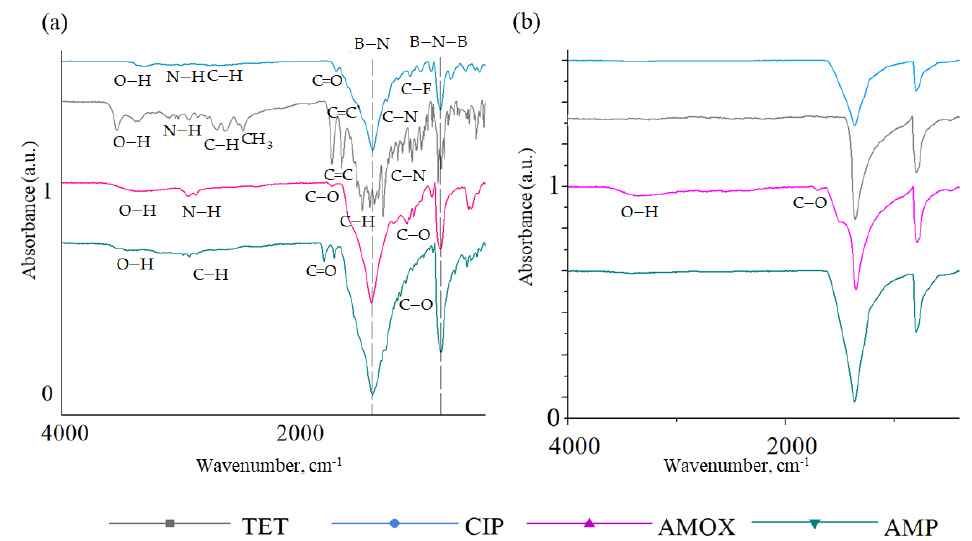
Figure 3. FTIR spectra of BN coatings before ( a ) and after ( b ) cleaning. The efficiency of antibiotic removal during coating reuse can be judged from the ki- netic curves shown in Figure 4. The removal efficiency also increases with increasing con- tact time; however, the removal rate is lower than in the first cycle. Data on the efficiency of the primary and reuse of samples coated with BN at pH 7 are presented in Table 2. It can be seen that, except for AMP, at a concentration of 50 µg/mL, R 100 is achieved over the same period. If we compare the R 100 and R 50 values on the 7 th day of purification in more detail, then the repeated use of coatings reduces the efficiency by 0.0–10.9% (TET), 1.5– 13.9% (CIP), 5.1–19.4% (AMOX), and 9.7–25.7% (AMP). It should be noted that there is no pronounced dependence of R on the initial concentration of the antibiotic when samples are reused. Table 2. Sorption efficiency during first (I) and second (II) cleaning cycle at pH 7.